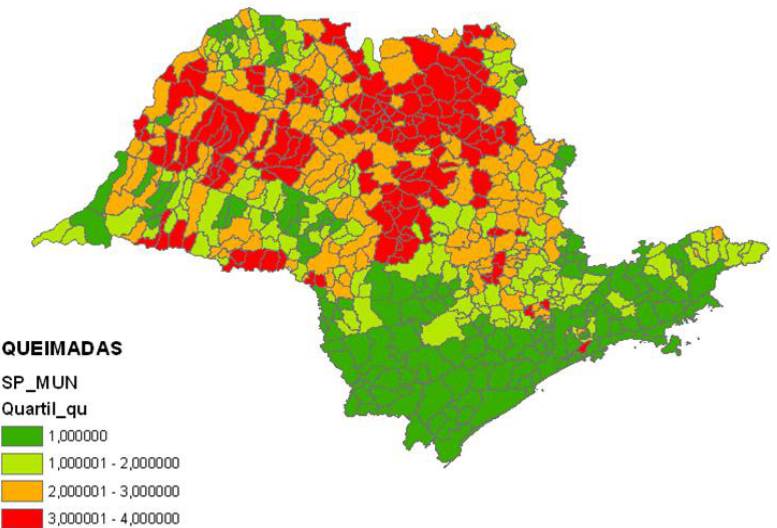
Figure 3. State of Sao Paulo, Brazil—Health risk factors from biomass burning: burning points/area.